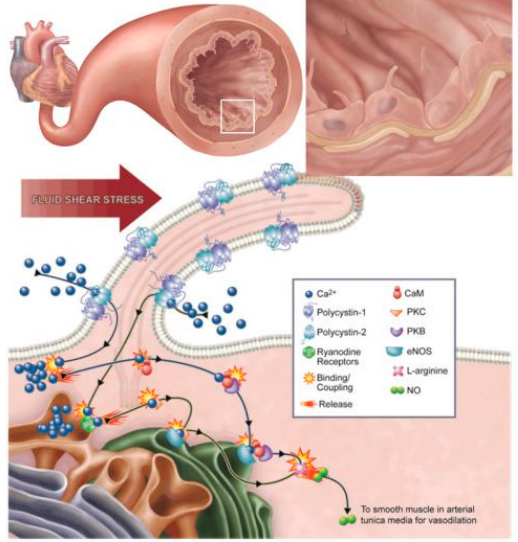
Figure 3. An illustration postulates endothelial primary cilia as regulators of blood pressure through nitric oxide production, which is transferred to the smooth muscle in arterial tunica media [51].